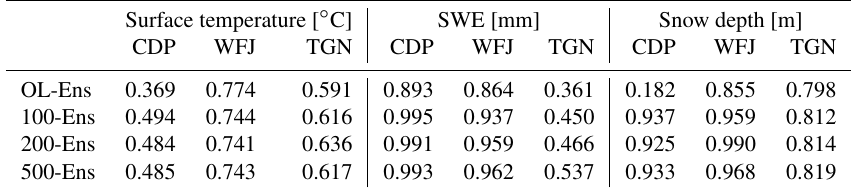
Table 7. nP-Exp: KGE values of the ensemble mean simulations as a function of the particle number. Surface temperature [ ◦ C] SWE [mm] Snow depth [m] CDP WFJ TGN CDP WFJ TGN CDP